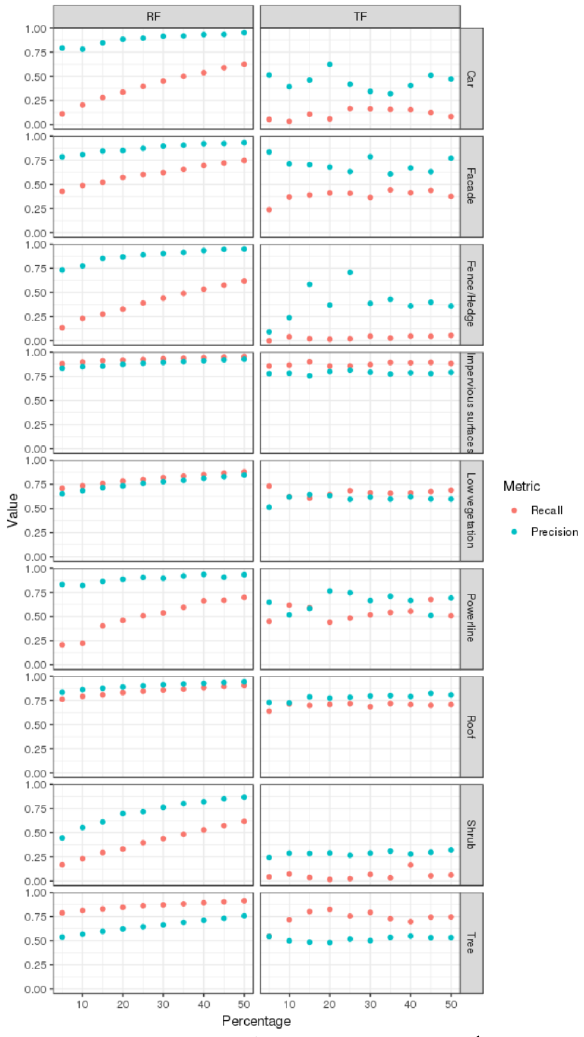
Figure 5. Comparison of accuracy metrics (recall and precision) for each class and method in function of percentage of data used for